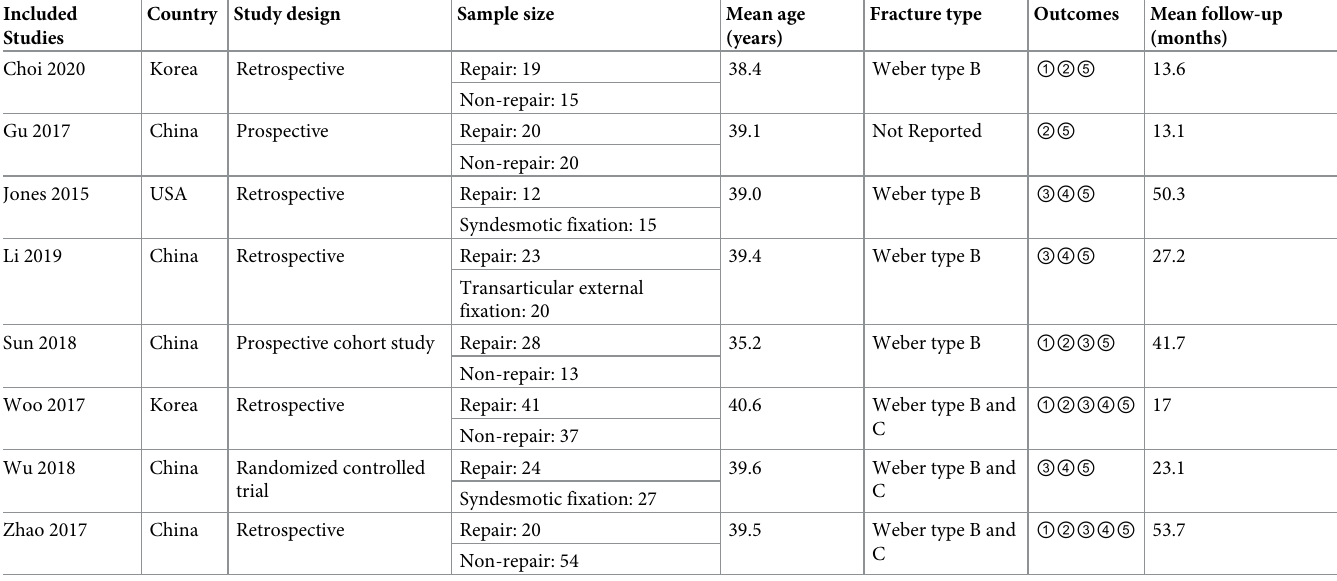
Table 1. Baseline characteristics of the included